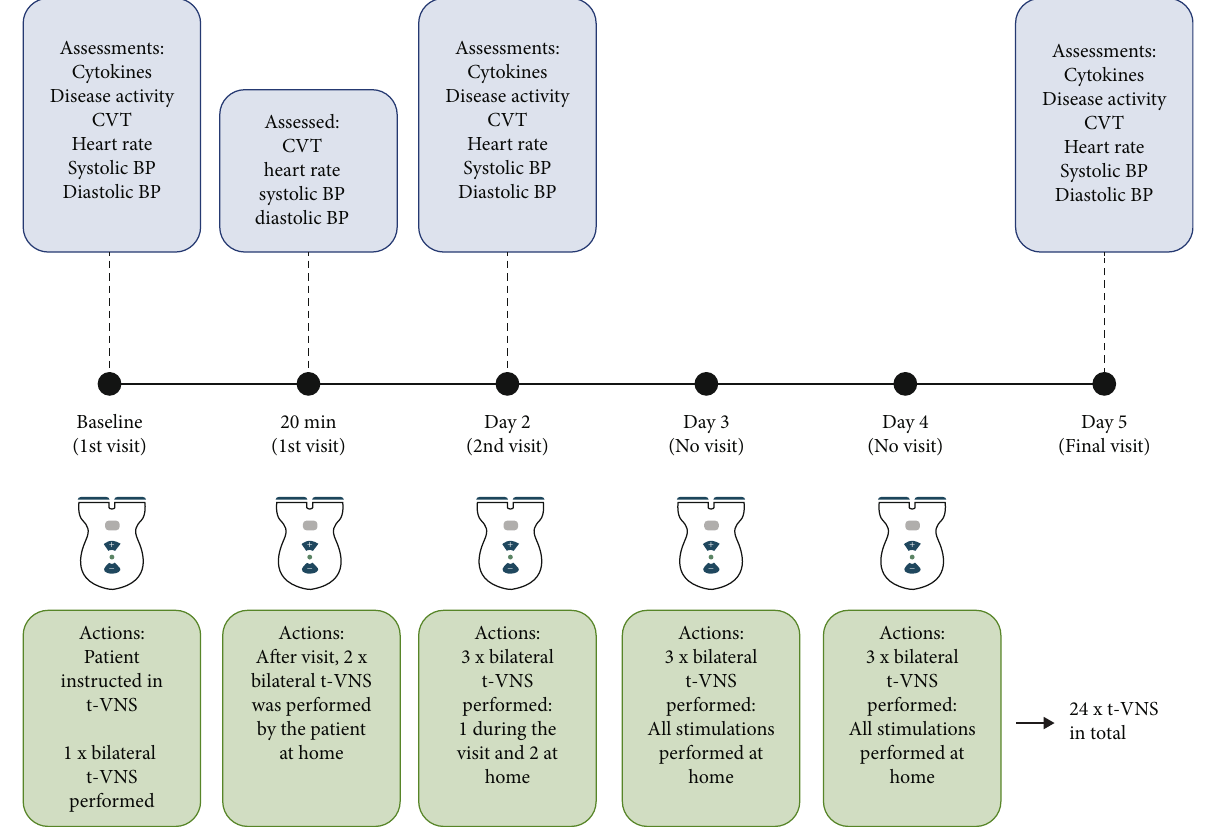
Figure 1: Schematic presentation of the study